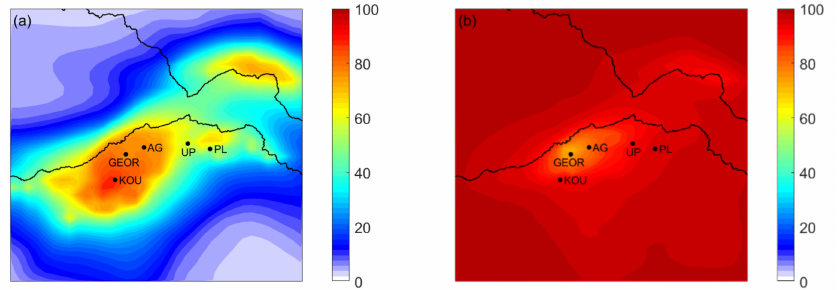
Figure 6. Contribution (%) of PM 2.5 from: ( a ) residential biomass burning to total PM 2.5 during December 2021 and ( b ) LRT to total PM 2.5 during July 2021 for the inner domain including Patras.